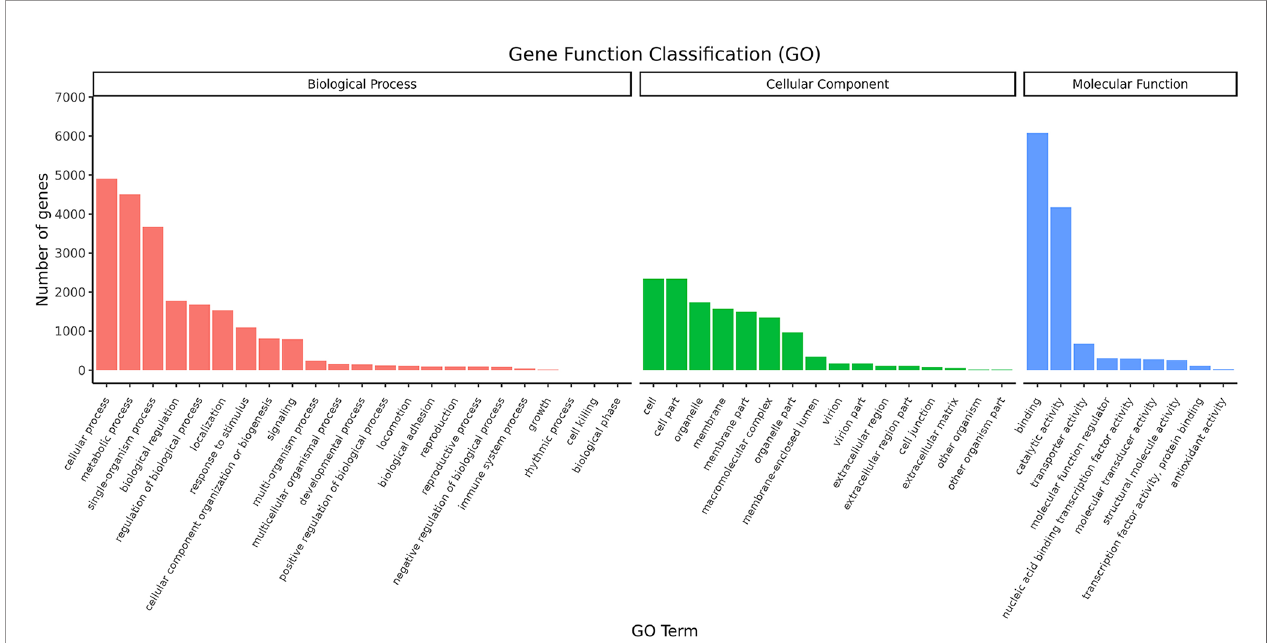
FIGURE 1 | GO classi fi cation of the